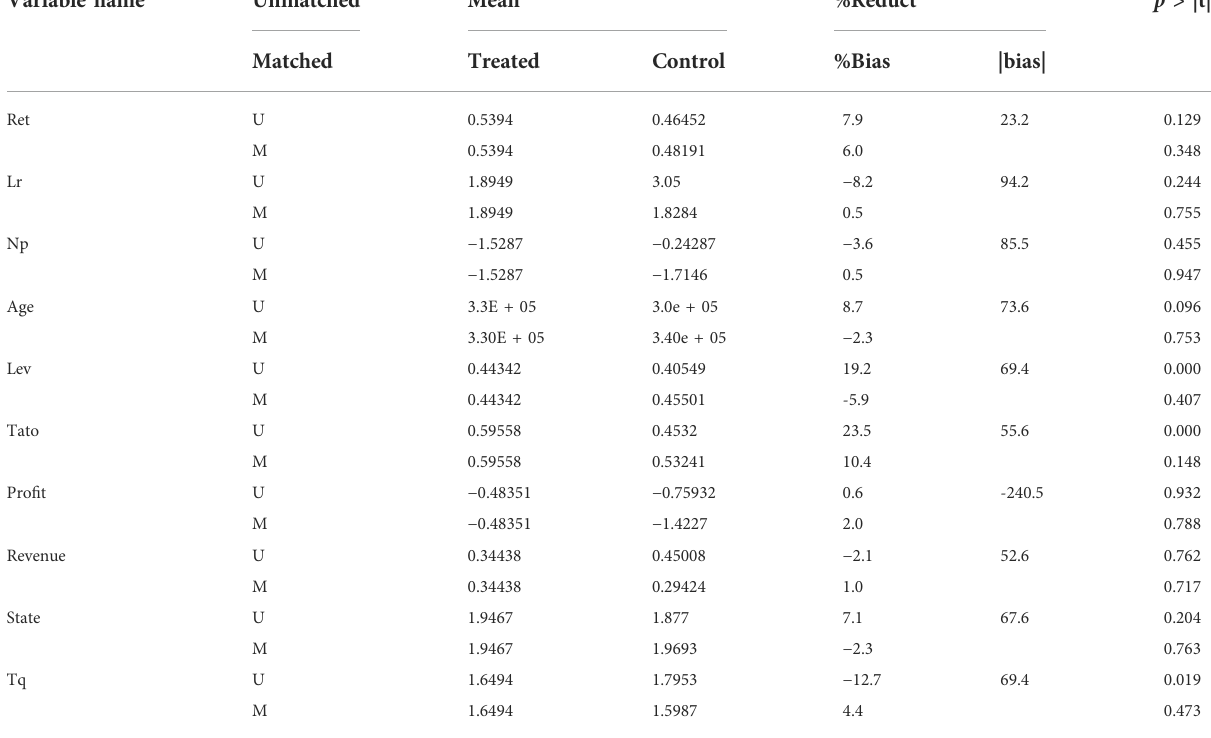
TABLE 3 Logit regression results and balance test